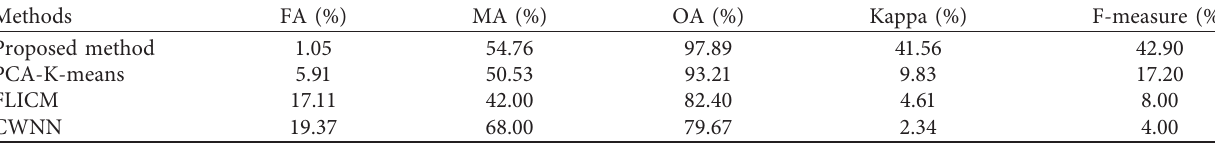
Table 4: Accuracy evaluation of the second comparative experiment of the second group of images.